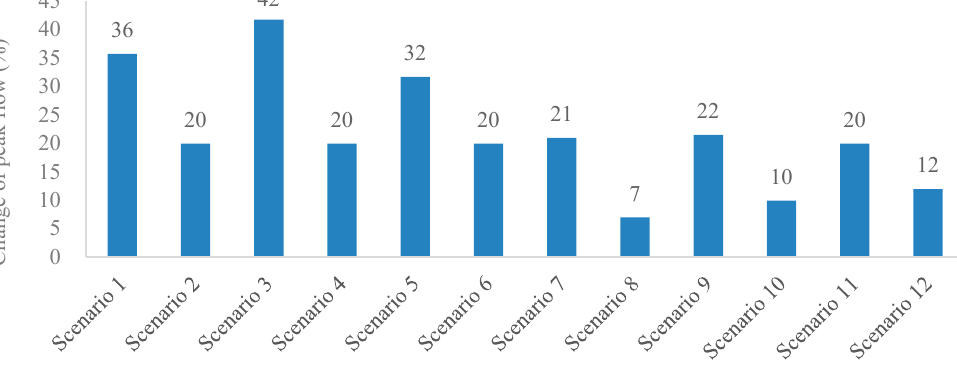
Figure 4. Percent of peak flow reduction by implementation of different permeable pavements.